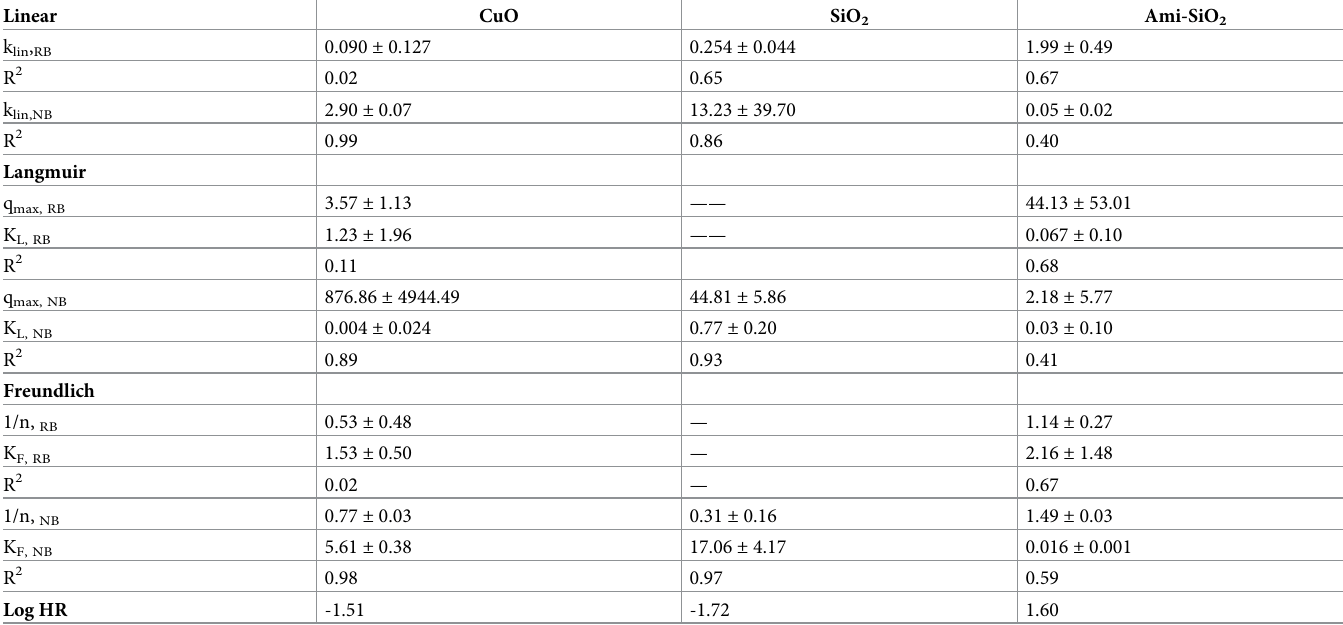
Table 1. Summary of isotherm